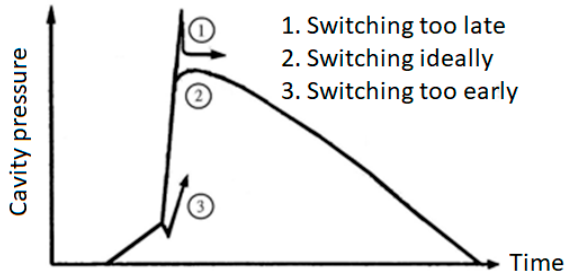
Figure 2. Three types of cavity pressure profiles correspond to switching times.